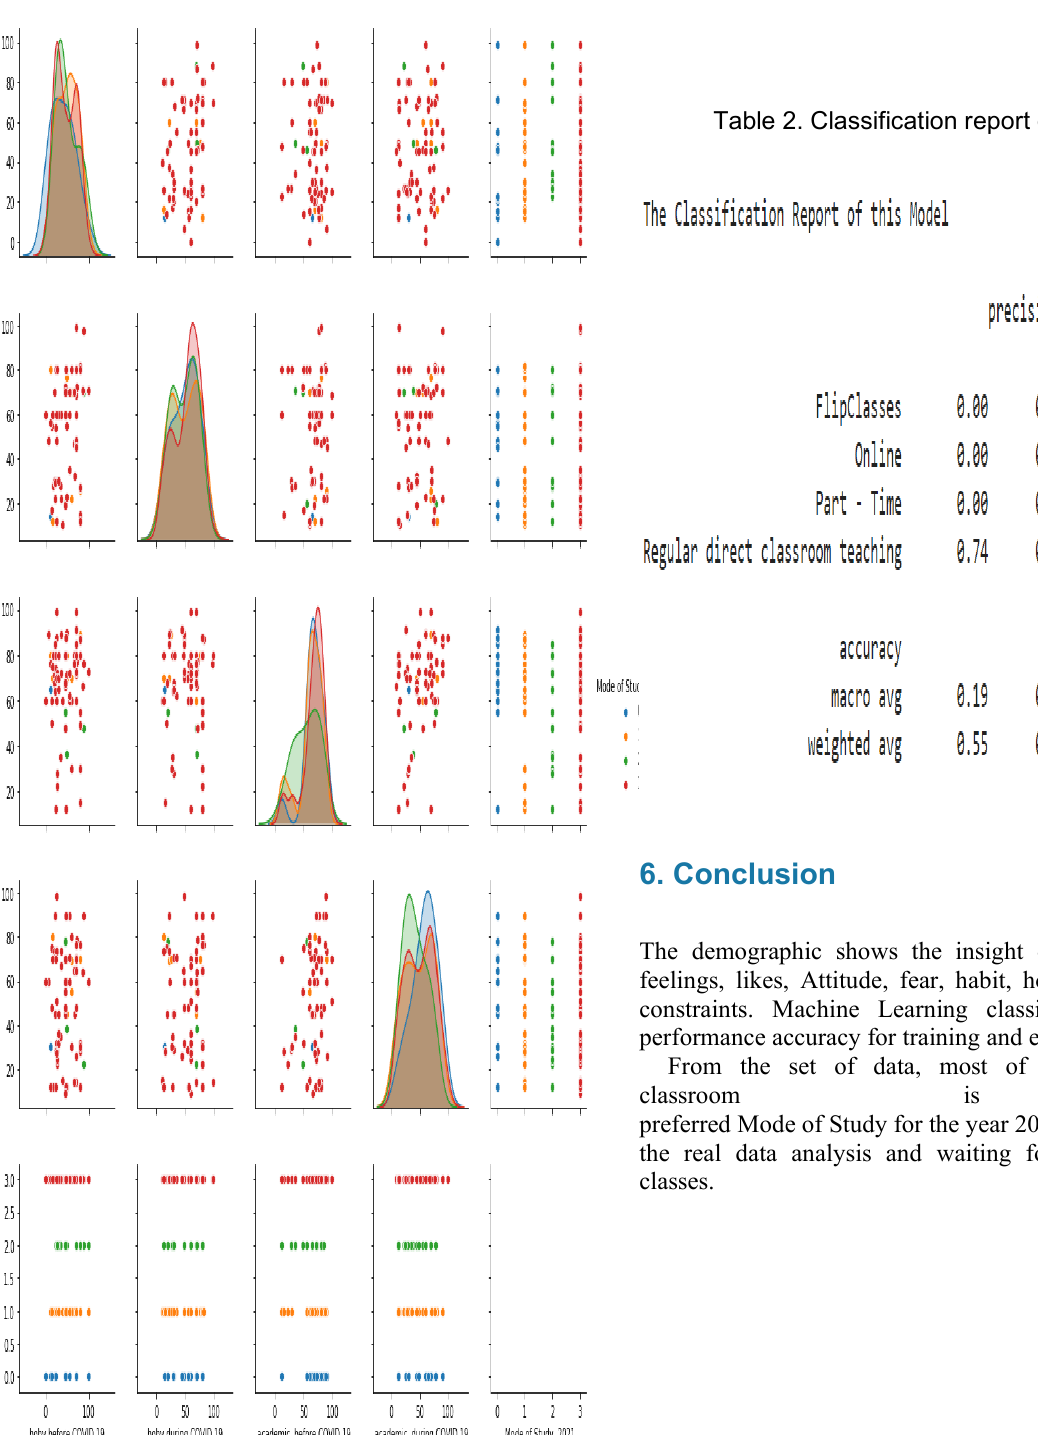
Figure 14. Teaching learning process based on Students’ View of Attending